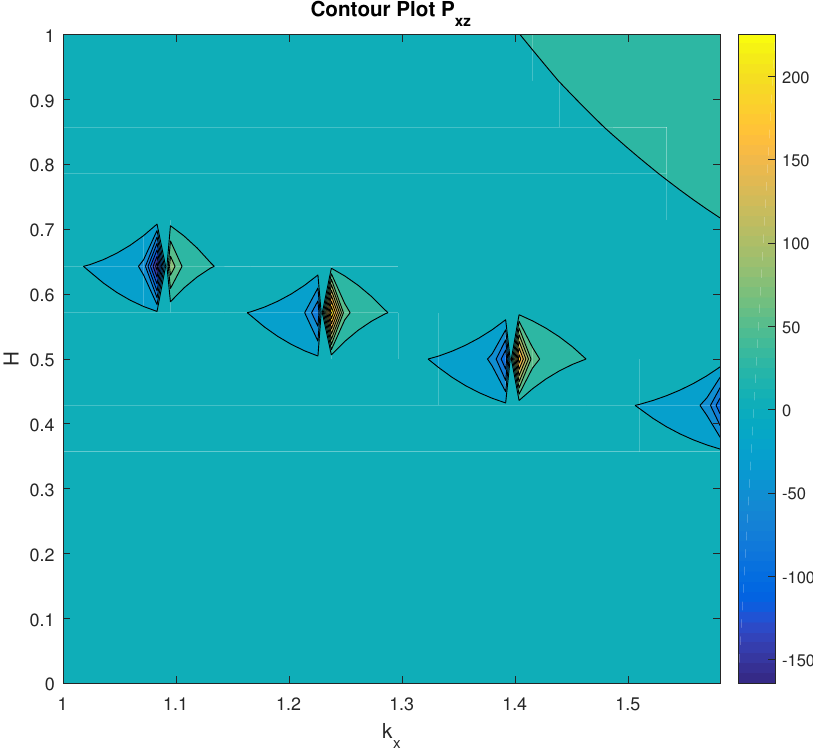
Figure 8. Contour plot of the dispersive coefficient component P xz . The variation is shown with respect to the quantum diffraction parameter H and wave vector ( k x